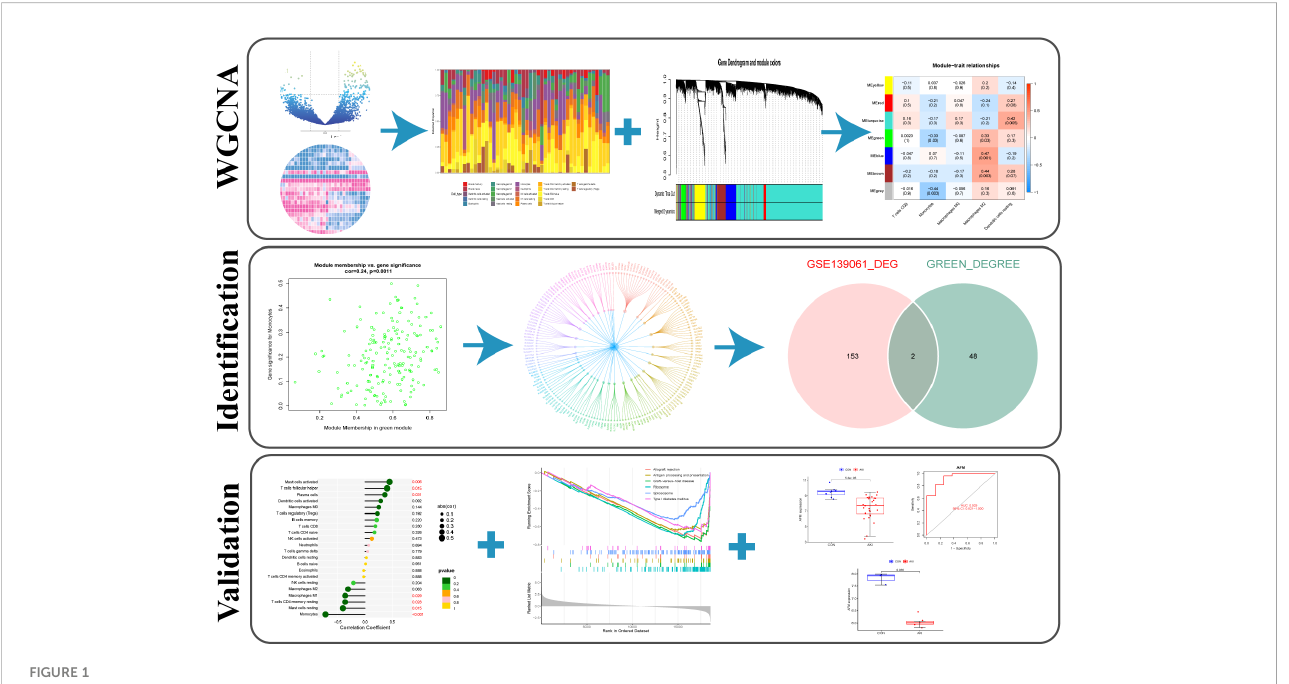
FIGURE 1 The work fl ow of the